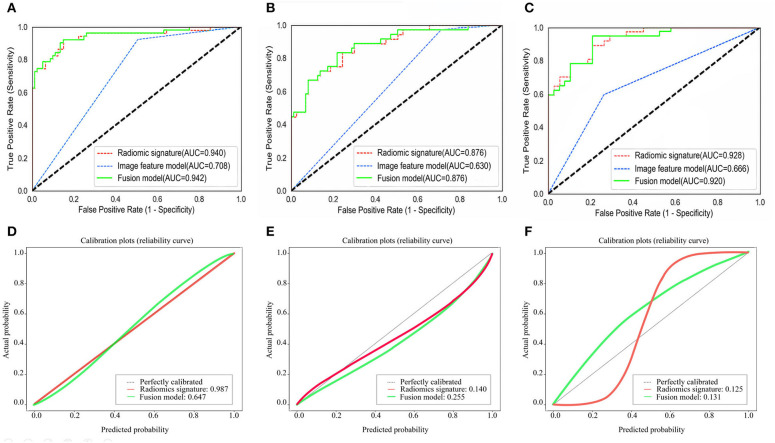
Comparison of ROC curves between radiomic signature, image feature model, and fusion model for prediction of tumor necrosis in the training cohort (A), the validation cohort 1 (B), and the validation cohort 2 (C). The three colors of the curves represent different models: green, radiomics signature; blue, image feature model; red, fusion model. Calibration curves of the radiomic signature, fusion model in the training cohort (D), the validation cohort 1 (E), and the validation cohort 2 (F), respectively. Calibration curves show the calibration of the nomogram in terms of agreement between the predicted probability of SSIGN risk group and actual probability. The 45 black lines represent a perfect prediction, and the green and red lines represent the predictive performance of the radiomic signature and the fusion model, respectively. The closer the dotted line fit is to the ideal line, the better the predictive accuracy of the model is.